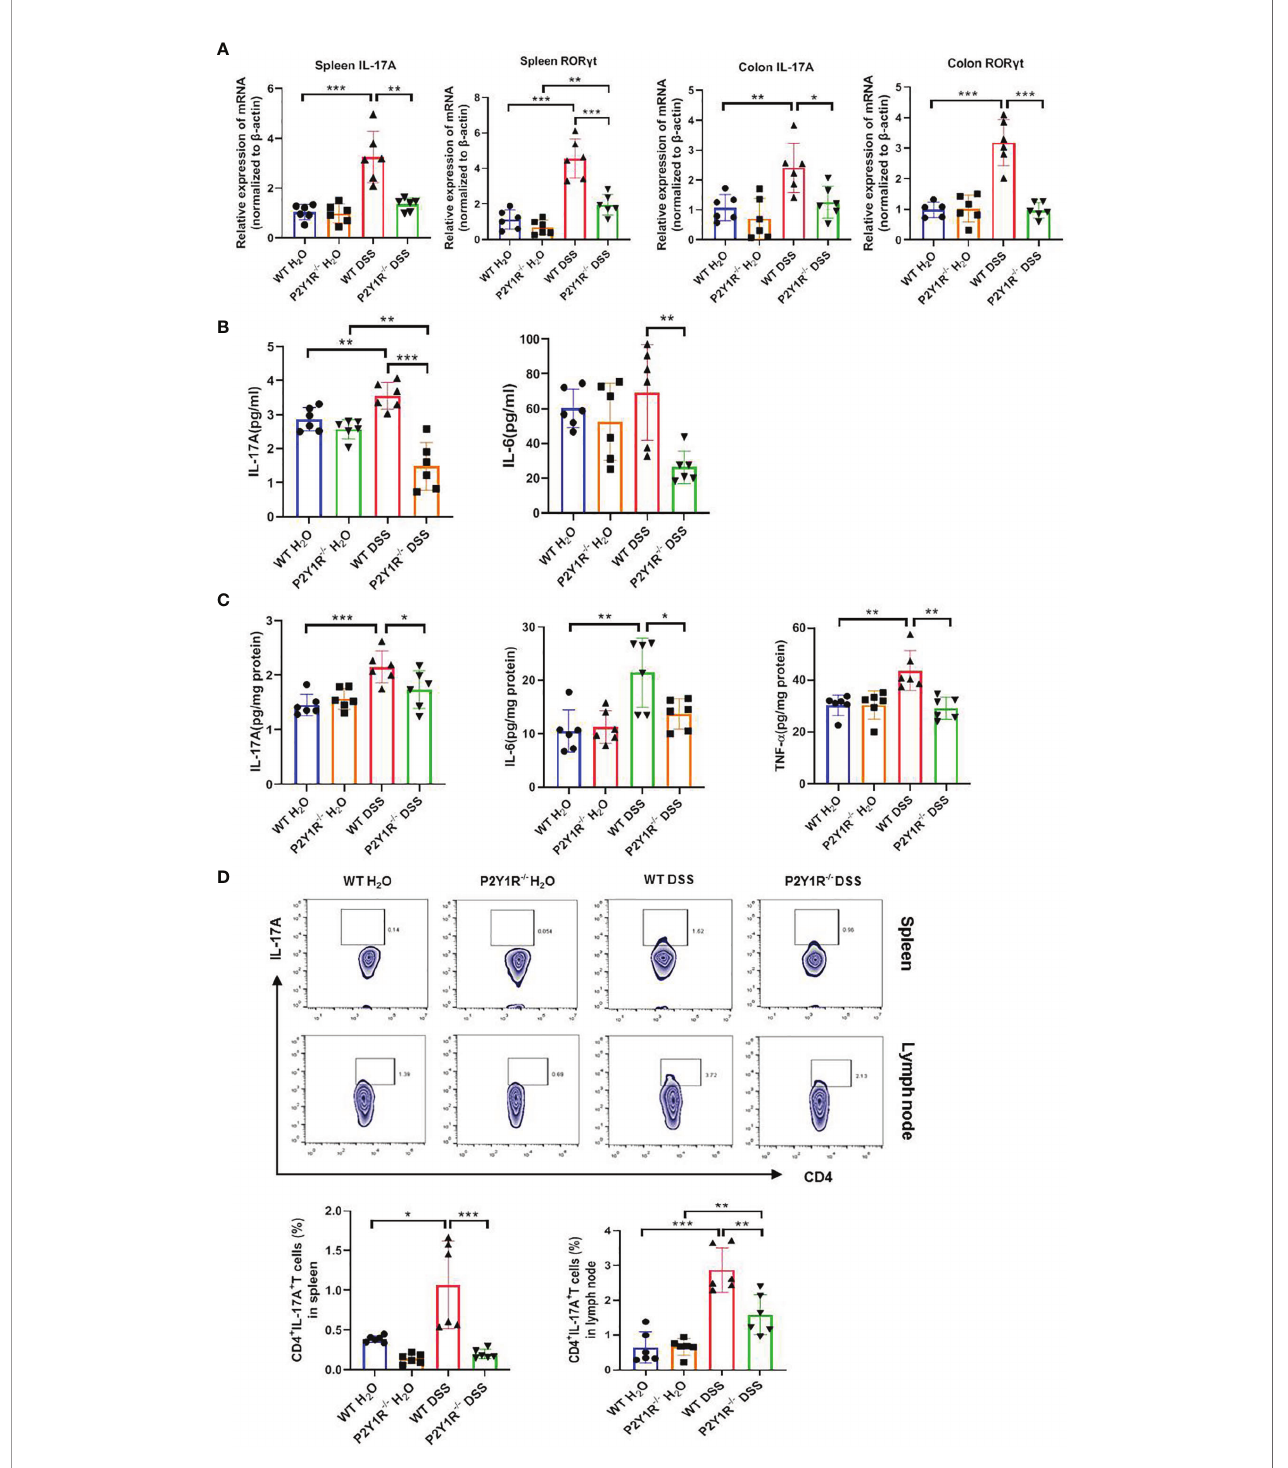
FIGURE 3 | P2Y1R de fi ciency suppresses Th17 responses of DSS-treated mice. (A) mRNA expression of IL-17A and ROR g t in the spleen and colon of DSS- treated P2Y1R -/- and WT mice. (B) Levels of proin fl ammatory cytokines IL-6 and IL-17A in the serum of DSS-treated P2Y1R -/- and WT mice. (C) Levels of proin fl ammatory cytokines IL-6, IL-17A and TNF- a in the colon tissues of DSS-treated P2Y1R -/- and WT mice. (D) The frequency of Th17 cells in the spleen and mesenteric lymph nodes (MLN) of both DSS-treated P2Y1R -/- and WT mice. Data are expressed as mean ± SEM (n=5-6). *p < 0.05, **p < 0.01 and ***p <